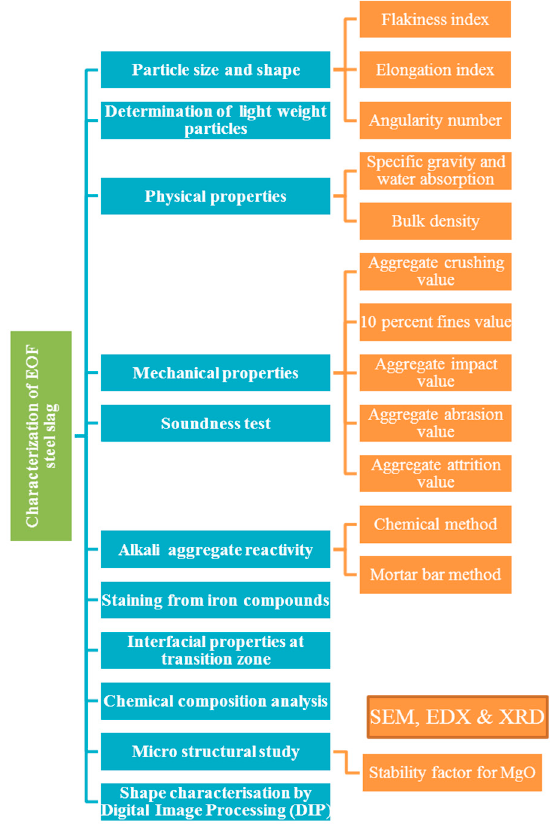
Figure 1. Framework of characterization